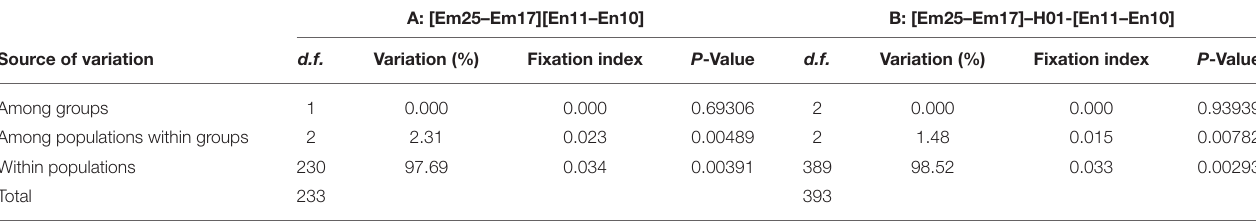
TABLE 3 | Hierarchical analysis of molecular variance (AMOVA).